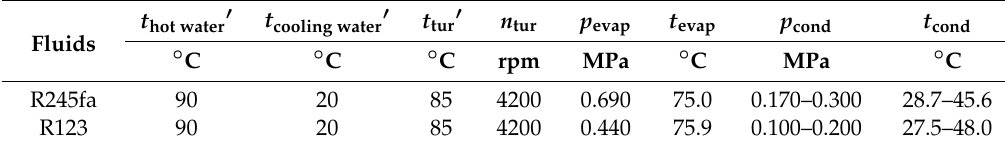
Table 4. Parameters range in Figure 8. Variation of thermal efficiency with evaporating temperature.